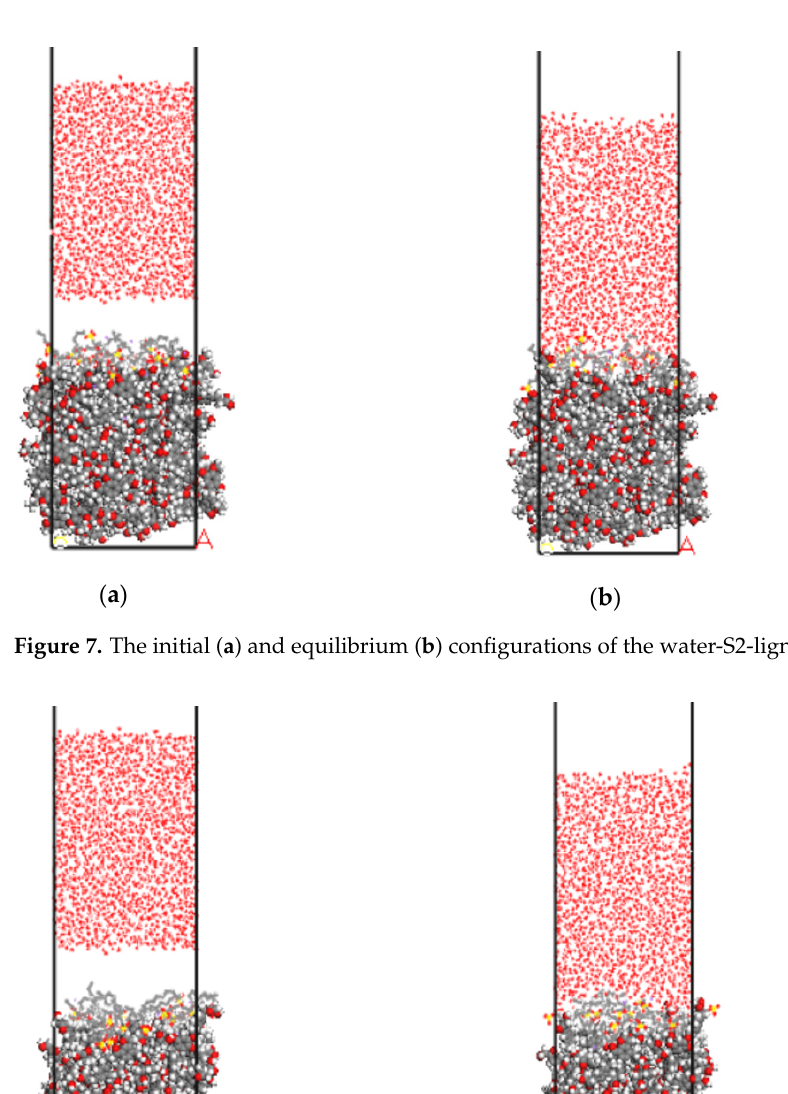
Figure 9. Relative concentration distribution of water molecules along the Z axis.